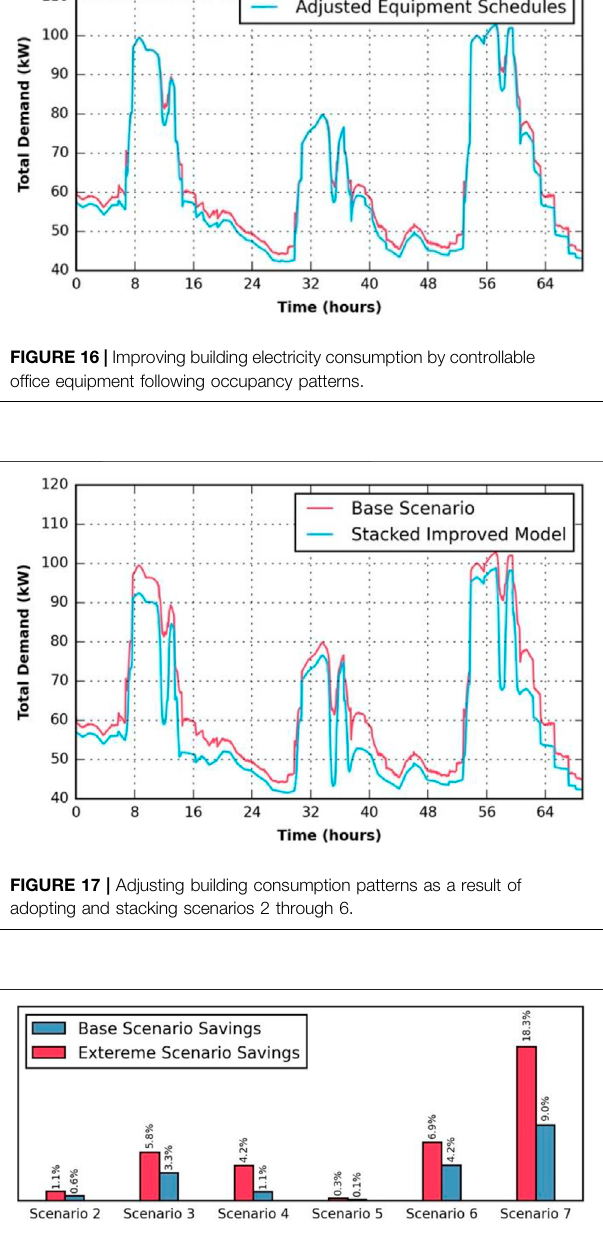
FIGURE 18 | Overall energy savings based on the different